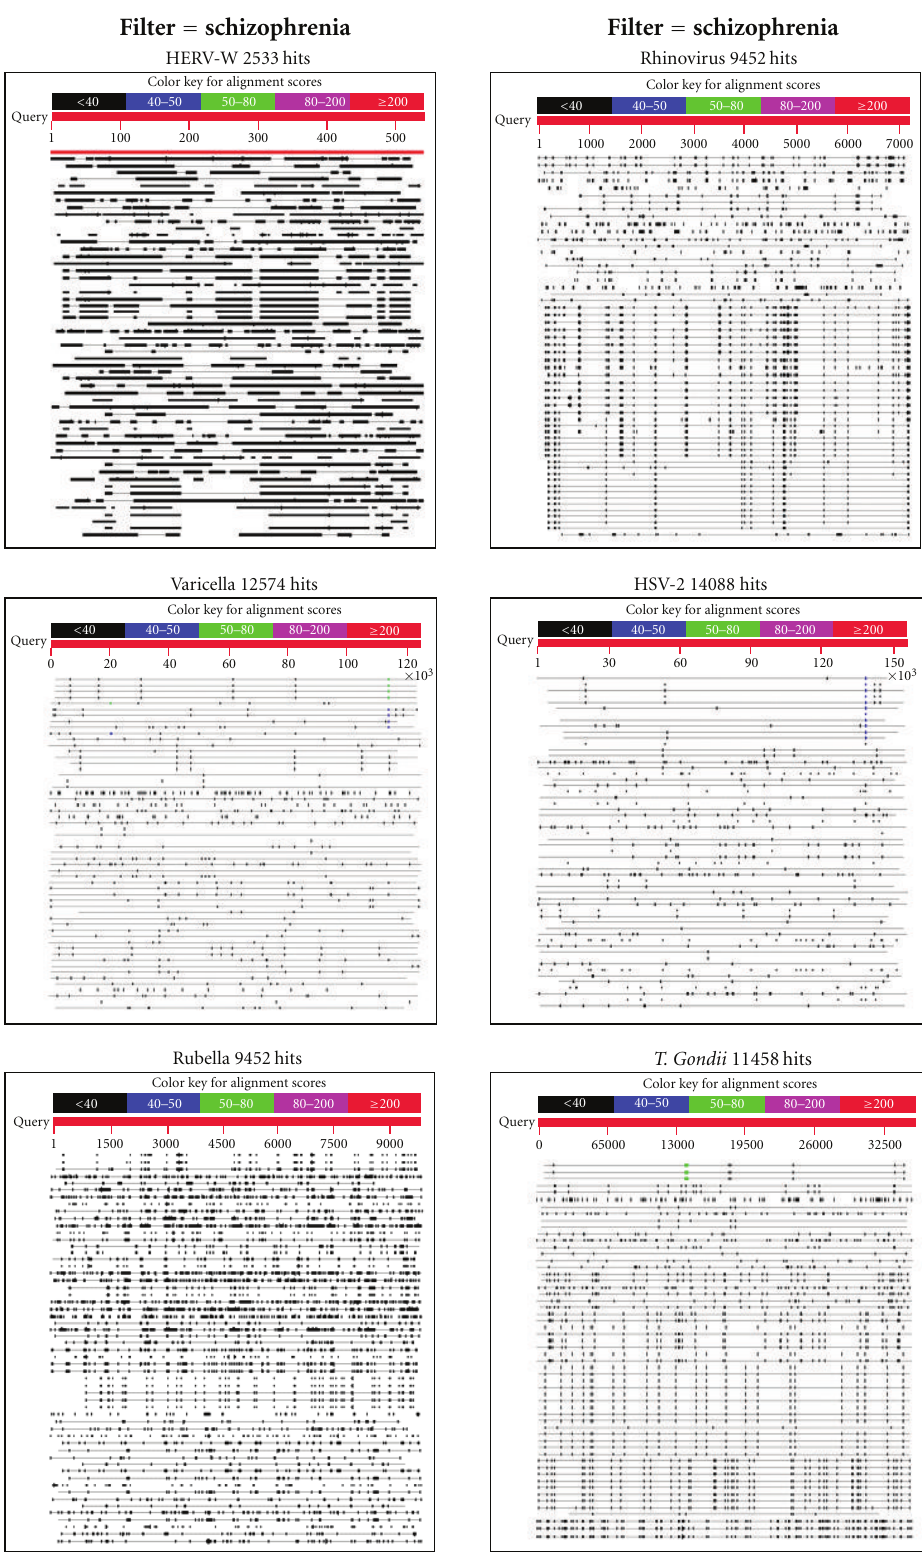
Figure 1: Screenshots of the pictorial representation of the viral BLAST results against the human proteome. The streaks dotted throughout the human genome/proteome represent the areas of homology, some with contiguous sequences of 5 or more amino acids. The number of hits is shown for each virus or pathogen. The figure also shows the total coverage of human chromosome 10 by viral gene homologues. The top set of figures were from unfiltered blasts while the bottom set of 6 figures represent filtered blasts using the query